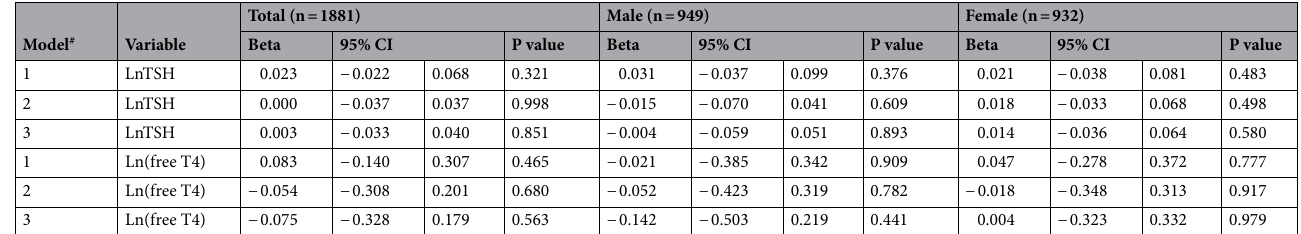
Table 4. Association between thyroid function and HOMA-IR index. # Model 1: linear regression analysis, 2: multiple regression analysis after adjustment for age, sex, systolic blood pressure, BMI, alcohol consumption, 3: multiple regression analysis after adjustment for age, sex, systolic blood pressure, waist circumference, alcohol consumption; TSH, free T4, and HOMA-IR are logarithmic-transformed. * P -values < 0.05 were considered as statistically